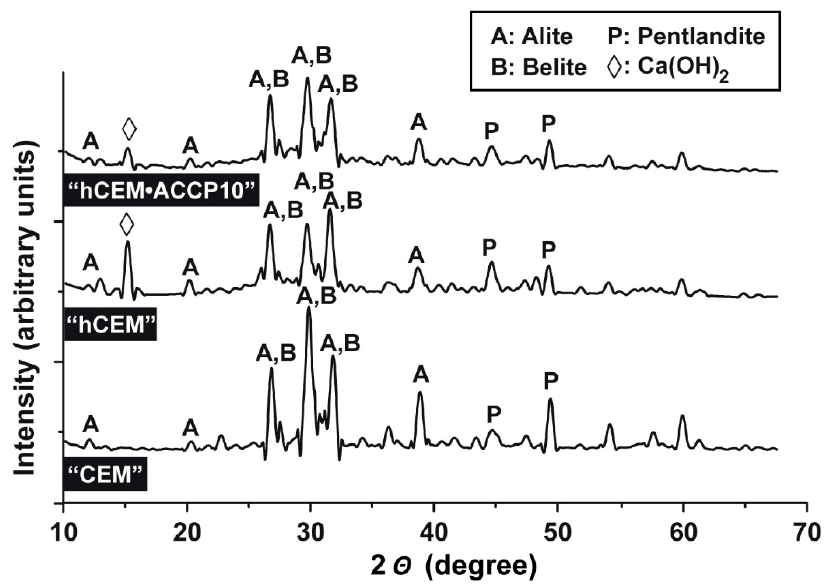
Figure 5. XRD patterns of “CEM”, “hCEM” and “hCEM • ACCP10”. The characteristic signals of alite, belite, pentlandite and Ca(OH) 2 are marked. The analysis of the hydrated cement samples, “hCEM” and “hCEM • ACCP10”, was performed after an aging period of 10 days. Molecules 2020 , 25 , x FOR PEER REVIEW